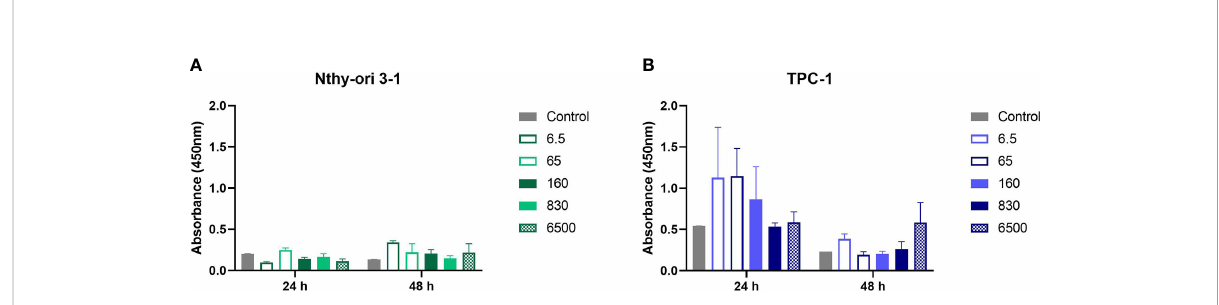
FIGURE 5 TPC-1 (A) and Nthy-ori 3-1 (B) cells were treated with increasing concentrations of Roundup ® Original DI for 24 h and 48 h. Cell proliferation was measured by the BrdU absorbance, and readings were corrected by subtracting the blank results. Data are presented as the mean ± SE.